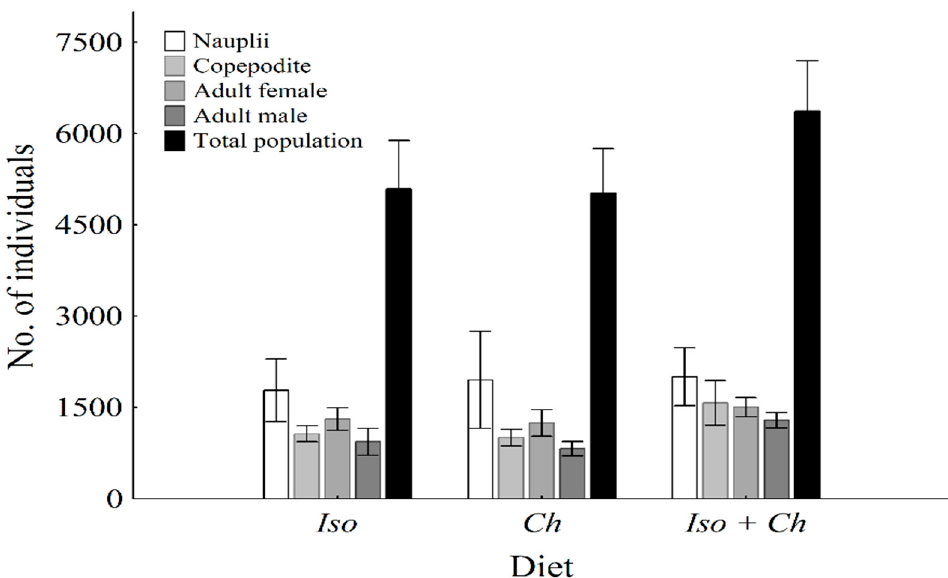
Figure 1. Total population after 16 days in a culture (individuals in 800 mL) of Oithona nana within the same stage between treatments. There was no difference found among the experimental groups. Descriptive errors bars, shown as average ± Standard Deviation ( n = 5).